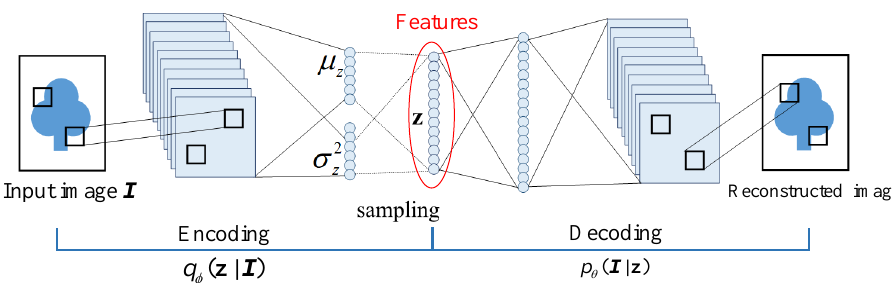
Figure 2. The structure of the VAE that is composed of the encoder and the decoder